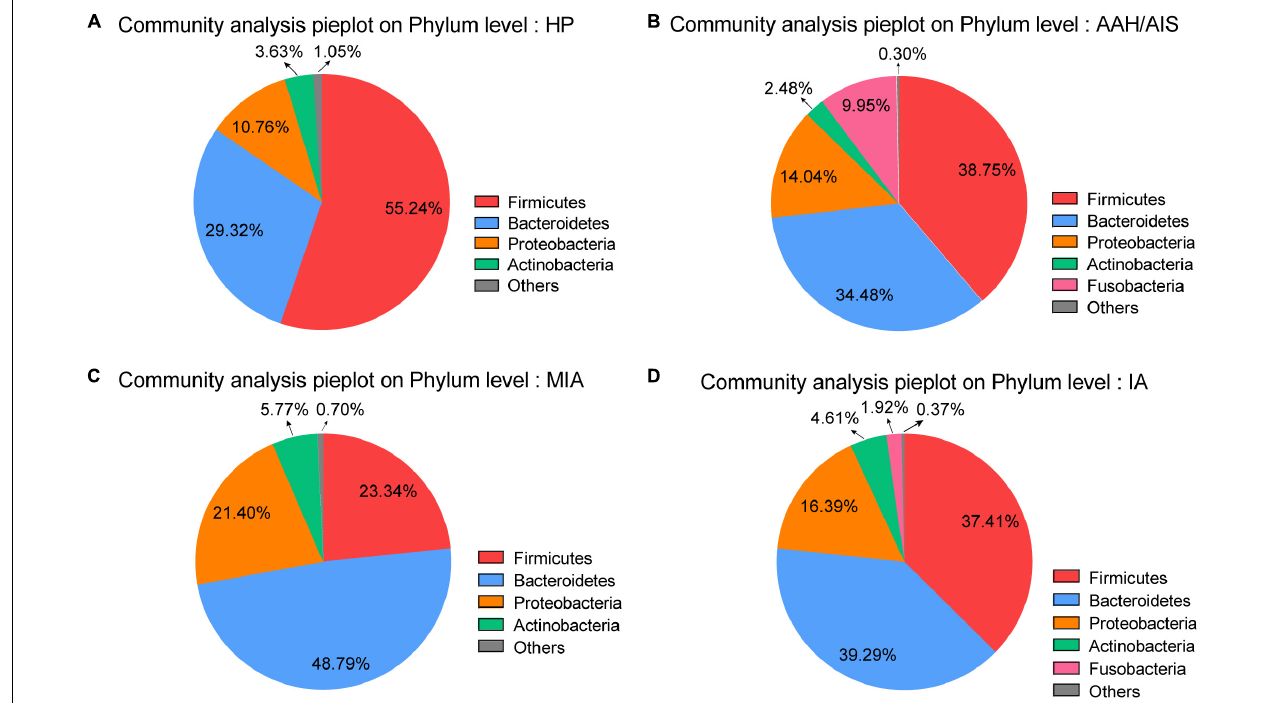
FIGURE 4 | Major OTUs at Phylum level in the HP group vs. the three lung cancer subgroups. (A) Major OTUs at Phylum level in the HP group. (B) Major OTUs at Phylum level in the AAH/AIS group. (C) Major OTUs at Phylum level in the MIA group. (D) Major OTUs at Phylum level in the IA